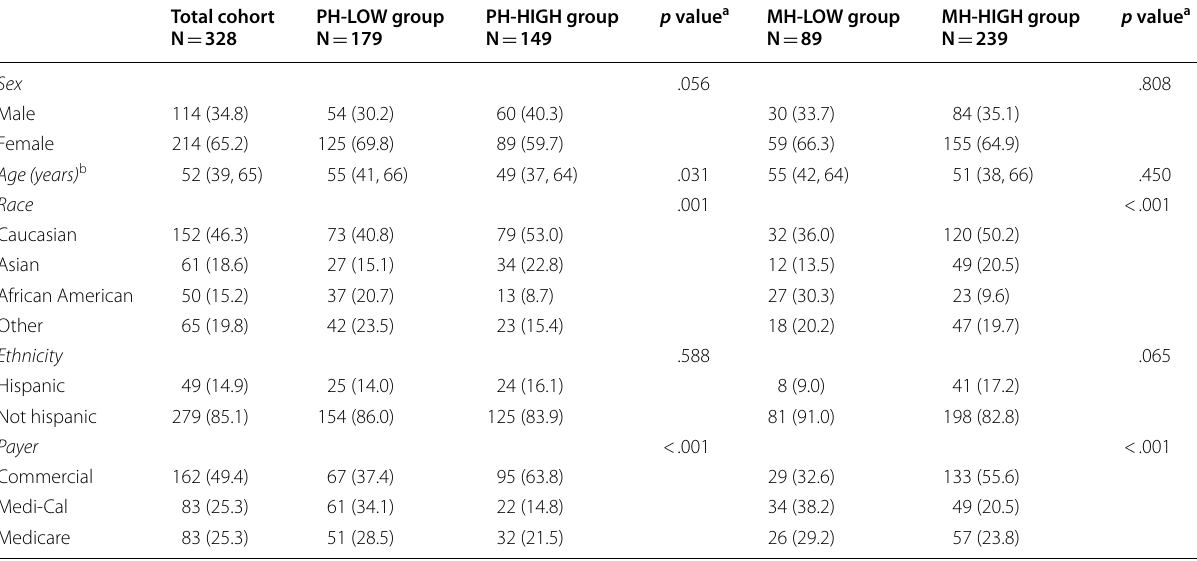
Table 1 Sociodemographic